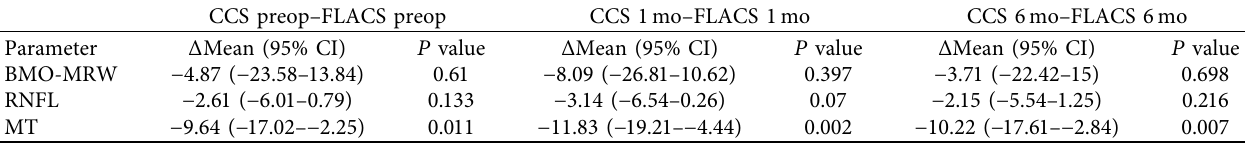
Table 4: Diference in BMO-MRW, RNFL and MT between CCS and FLACS groups in the three follow-up visits. CCS preop–FLACS